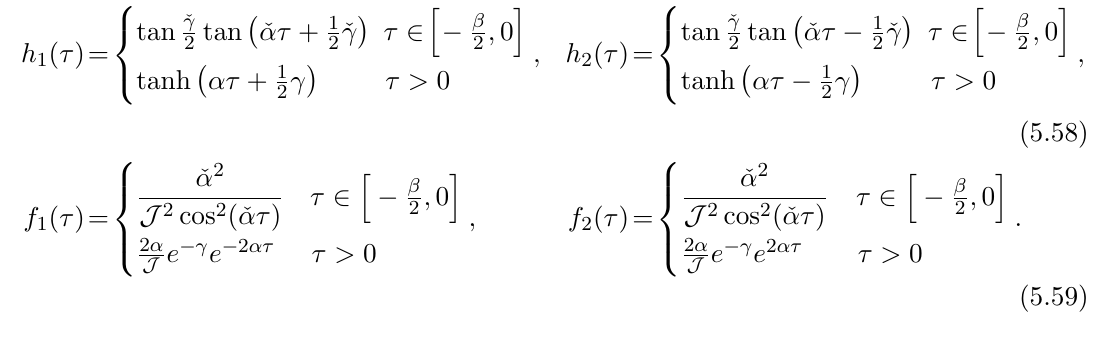
with the region dependent